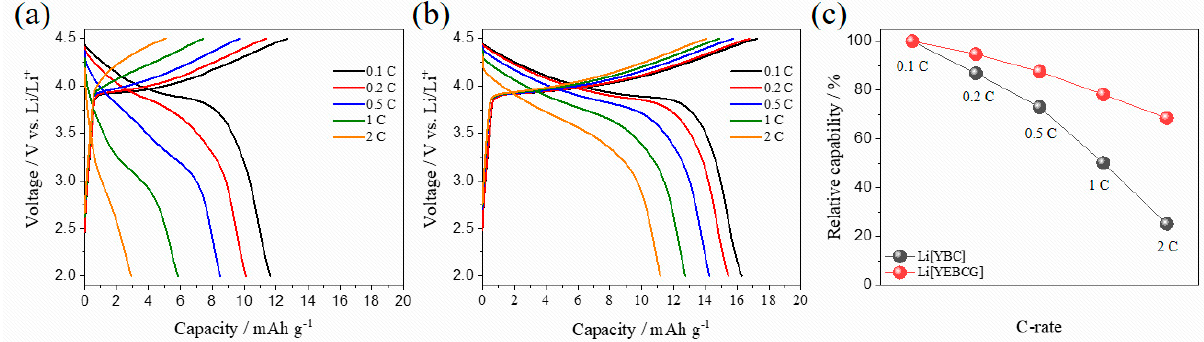
Figure 8. Rate capability of ( a ) Li[YBC] and ( b ) Li[YEBCG], and ( c ) their relative capability at various discharging C-rates from 0.1 to 2 C with a fixed charging C-rate of 0.1 C.